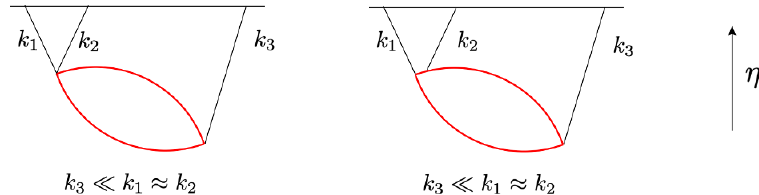
Figure 3 . Massive charged particle mediated (in red) loop level \in-in" contributions to the in(cid:13)aton (in black) three point function. Depending on the number of massive charged particle propagators, these diagrams are labelled from left to right: (a) double exchange diagram, (b) triple exchange diagram. (cid:17) denotes conformal time which ends at the end of